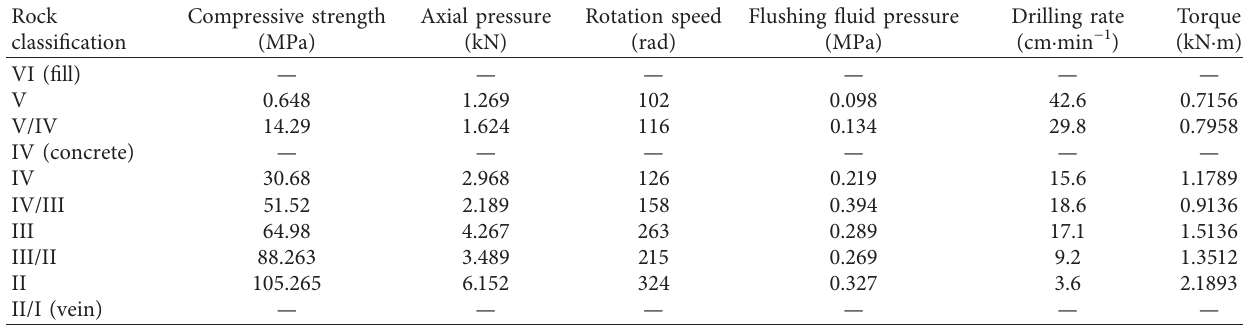
Table 11: Drilling parameters of hole 4.